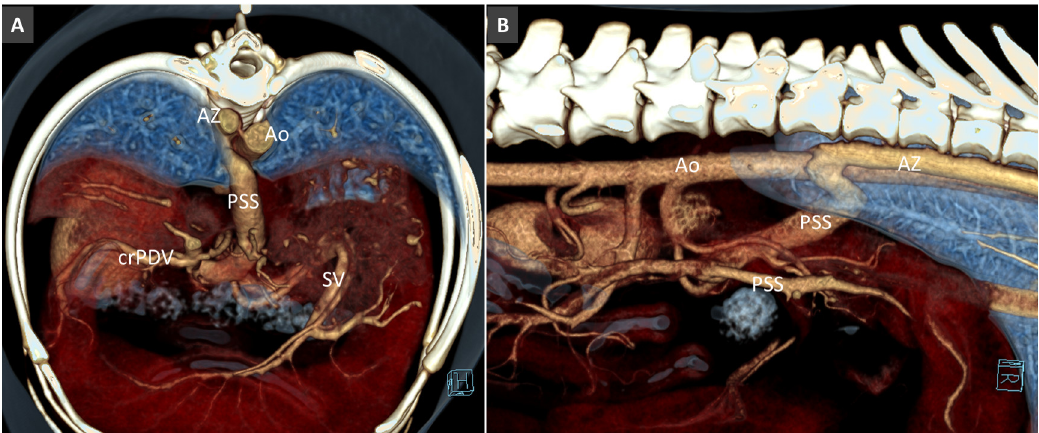
Figure 16. Congenital extrahepatic PSS in a dog, from left gastric vein to the right azygos vein (Az). ( A ). Volume rendered image, frontal view. ( B ). Right lateral view, showing the course and termination of the shunting vessel into the right azygous vein.